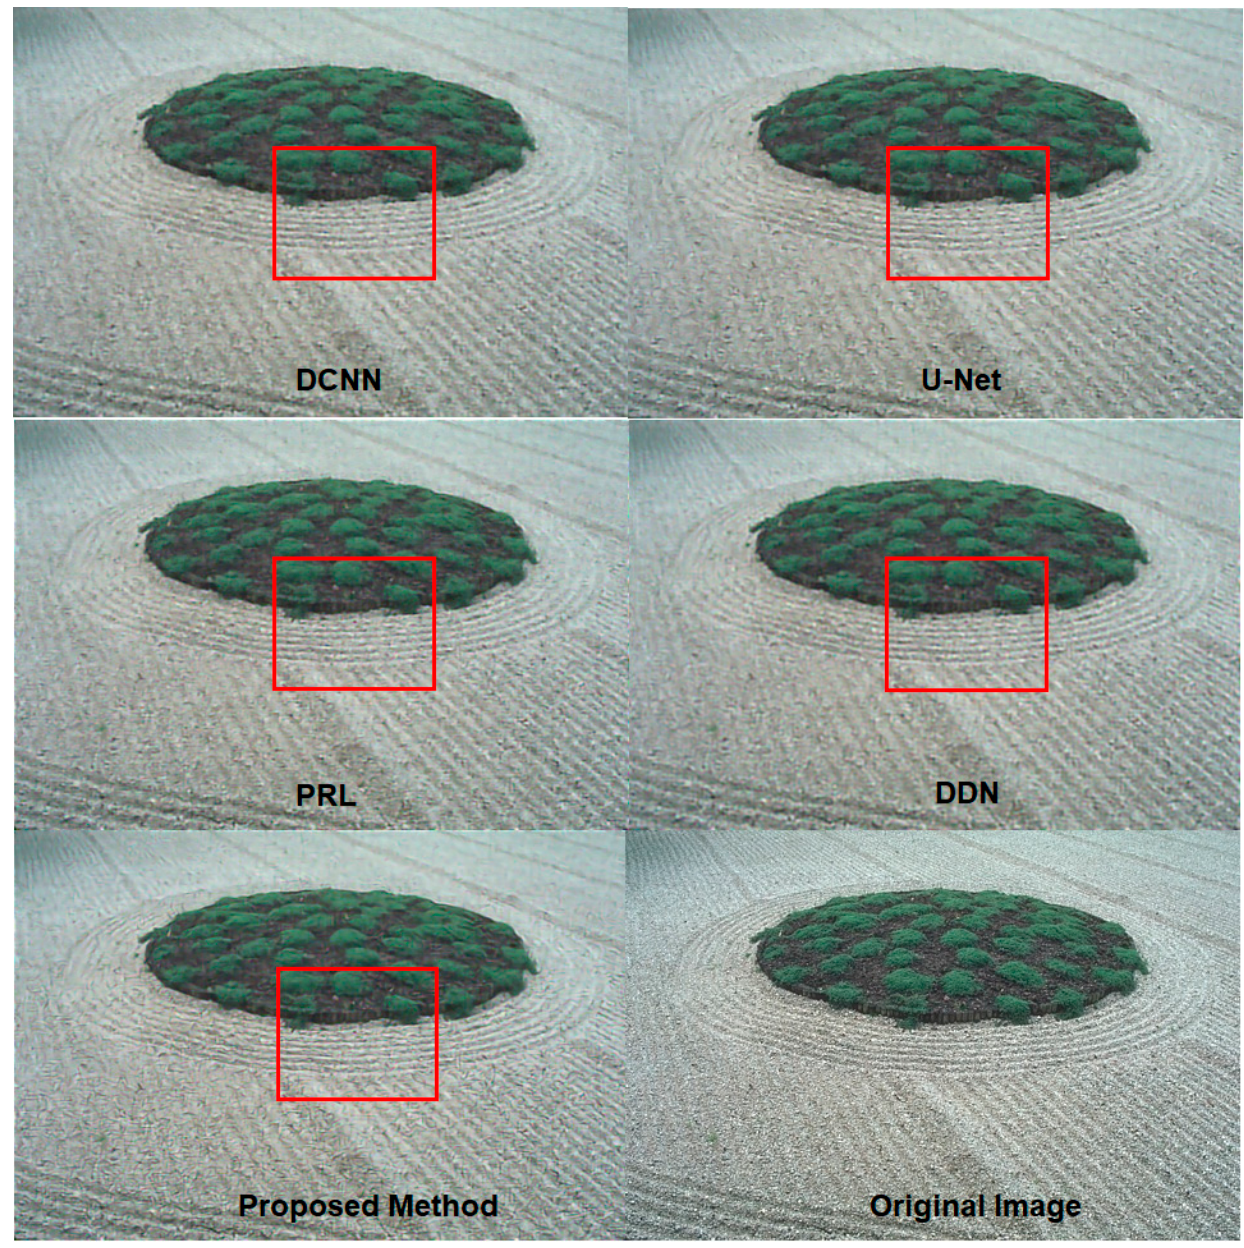
Figure 8. Experimental results for BSDS100.